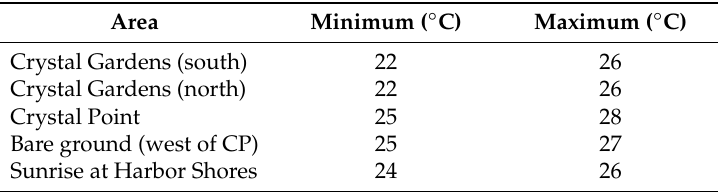
Table 2. Nighttime surface